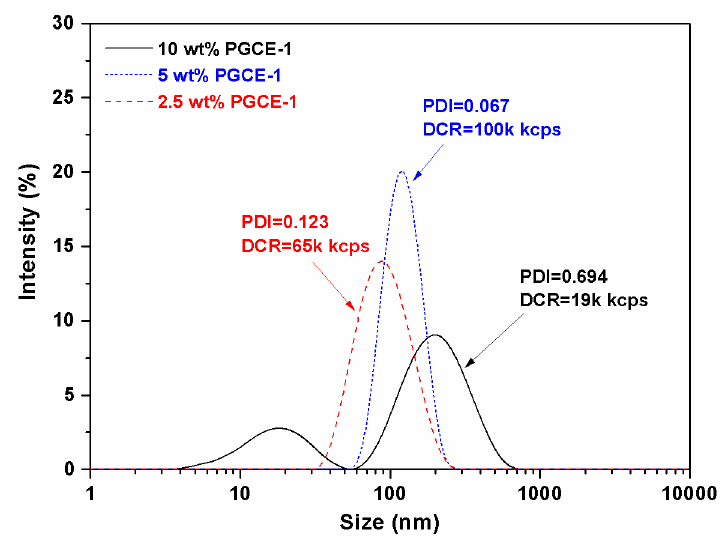
Figure 4. Diameters, polydispersity index (PDI) of size distributions, and scattering intensities (derived count rate : DCR) of PGCE ‐ 1 aqueous solutions with different concentrations.